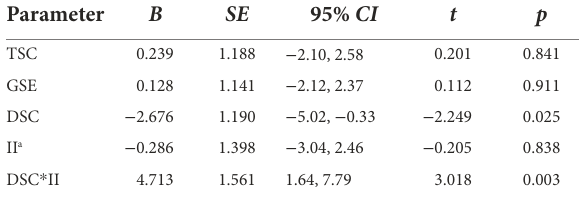
TABLE 2 Study 2: Regression analysis for predicting performance on a self-control task by desire for self-control and implementation intention (controlling for trait self-control and general